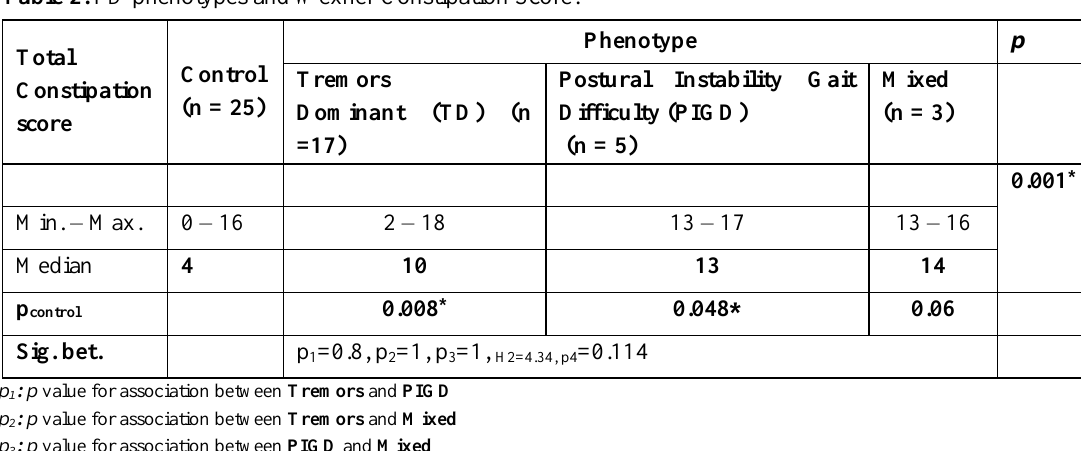
Table 2. PD phenotypes and Wexner Constipation Score.